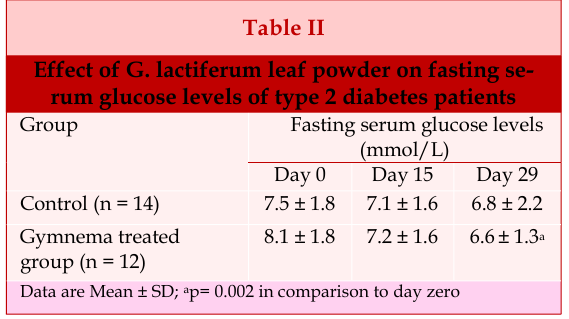
Effect of G. lactiferum leaf powder on postprandial blood glucose levels of type 2 diabetes